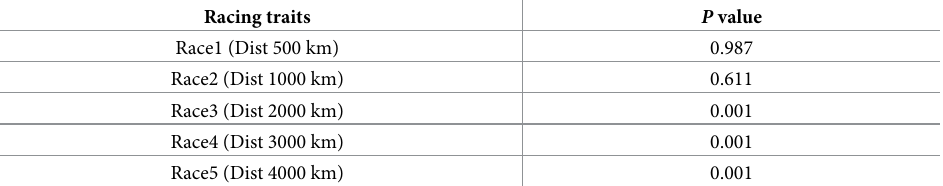
Table 4. Effect of LDHA genotypes (presence of allele S ) on the five studied racing traits.